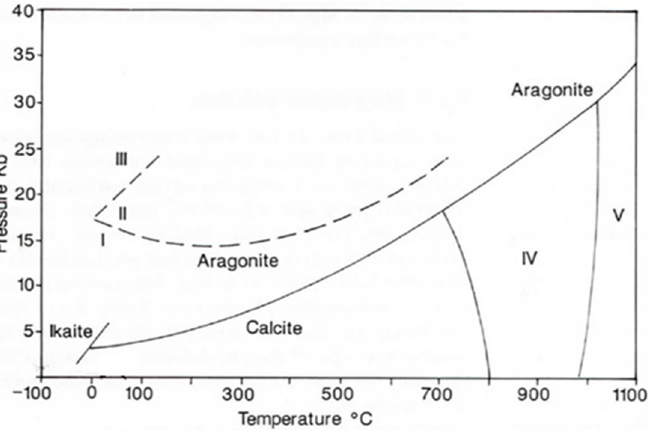
Figure 5. Stability diagram of calcite-aragonite. I–V, calcite intermediate polymorphs